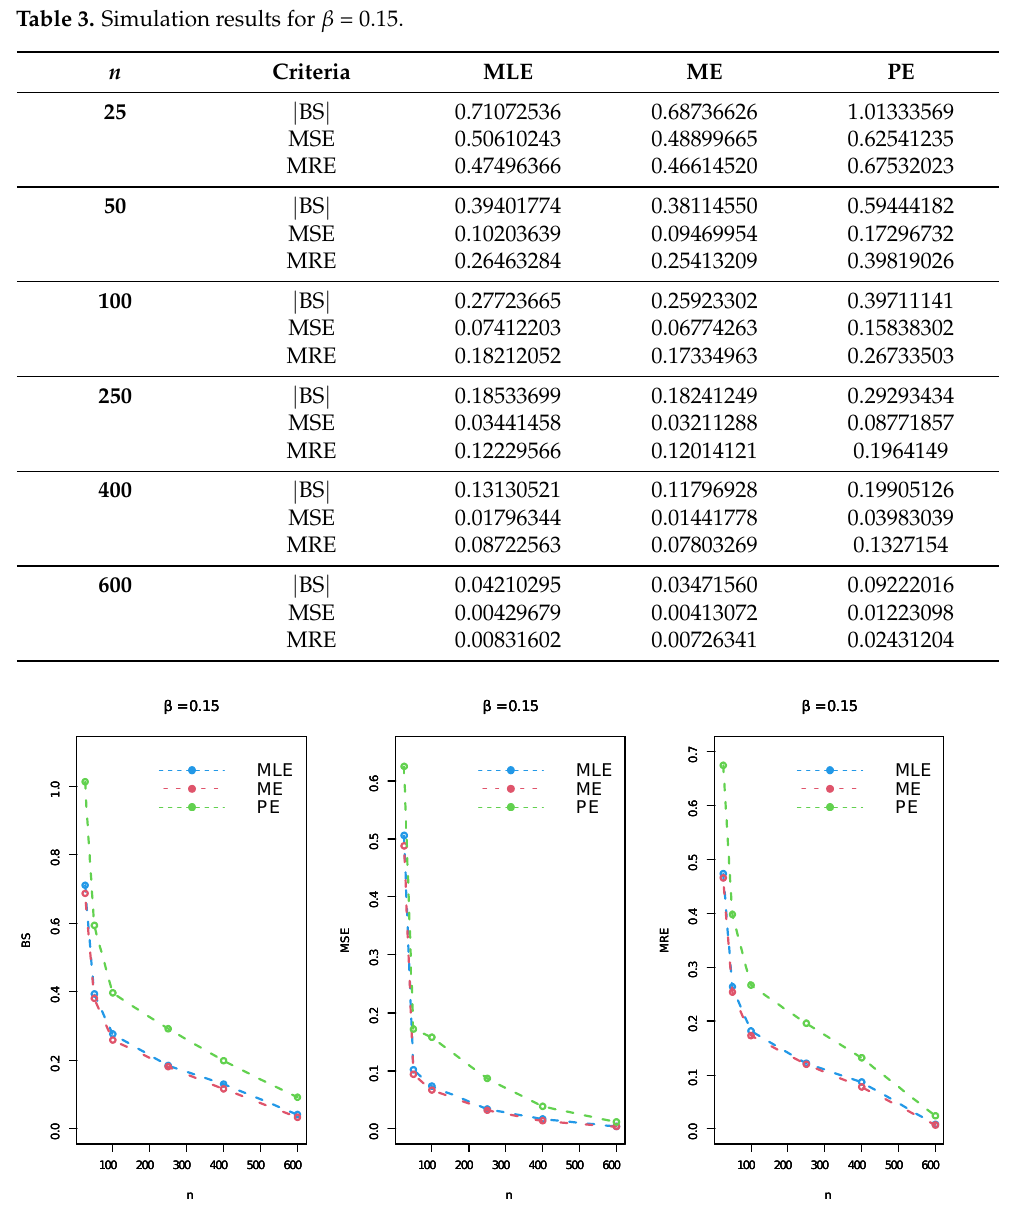
Table 3. Simulation results for β = 0.15.